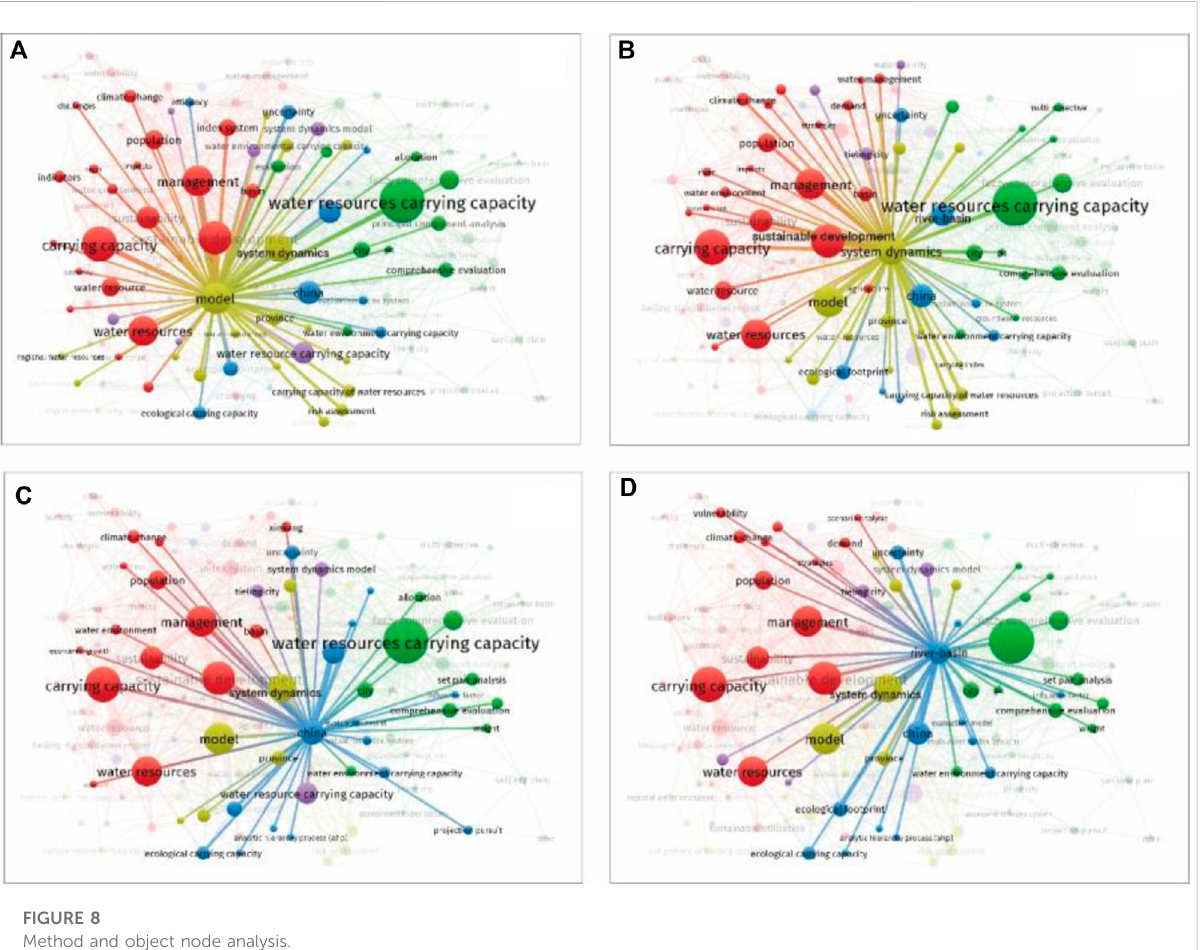
FIGURE 8 Method and object node